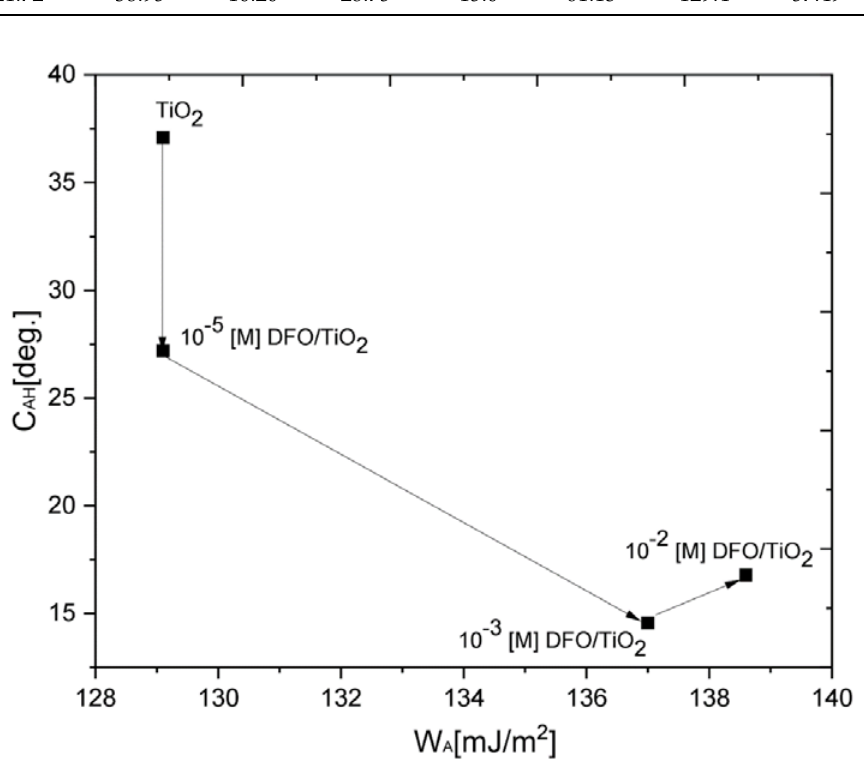
Table 2. Wettability parameters (mean values) of studied solid substrata in contact with distilled water, ϒ W = 72.77, T = 23.3 °C, Wc = 145.54 mJ/m 2 .